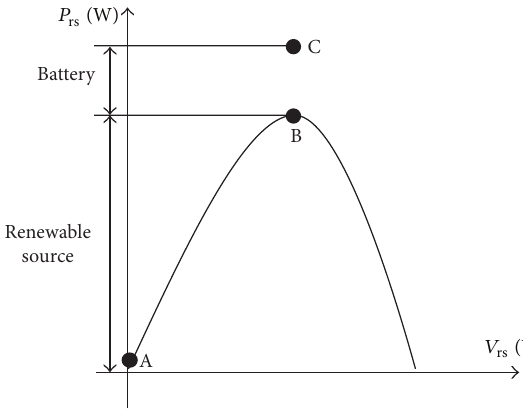
Figure 7: Characteristic waveforms of renewable sources and different power